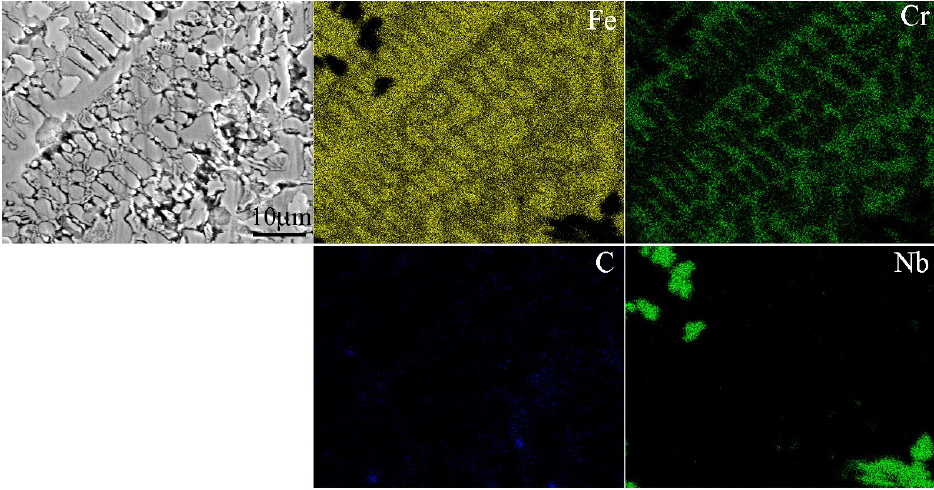
Figure 5. SEM image and EDS element distribution maps of Alloy E Figure 5 . SEM image and EDS element distribution maps of Alloy E coating.